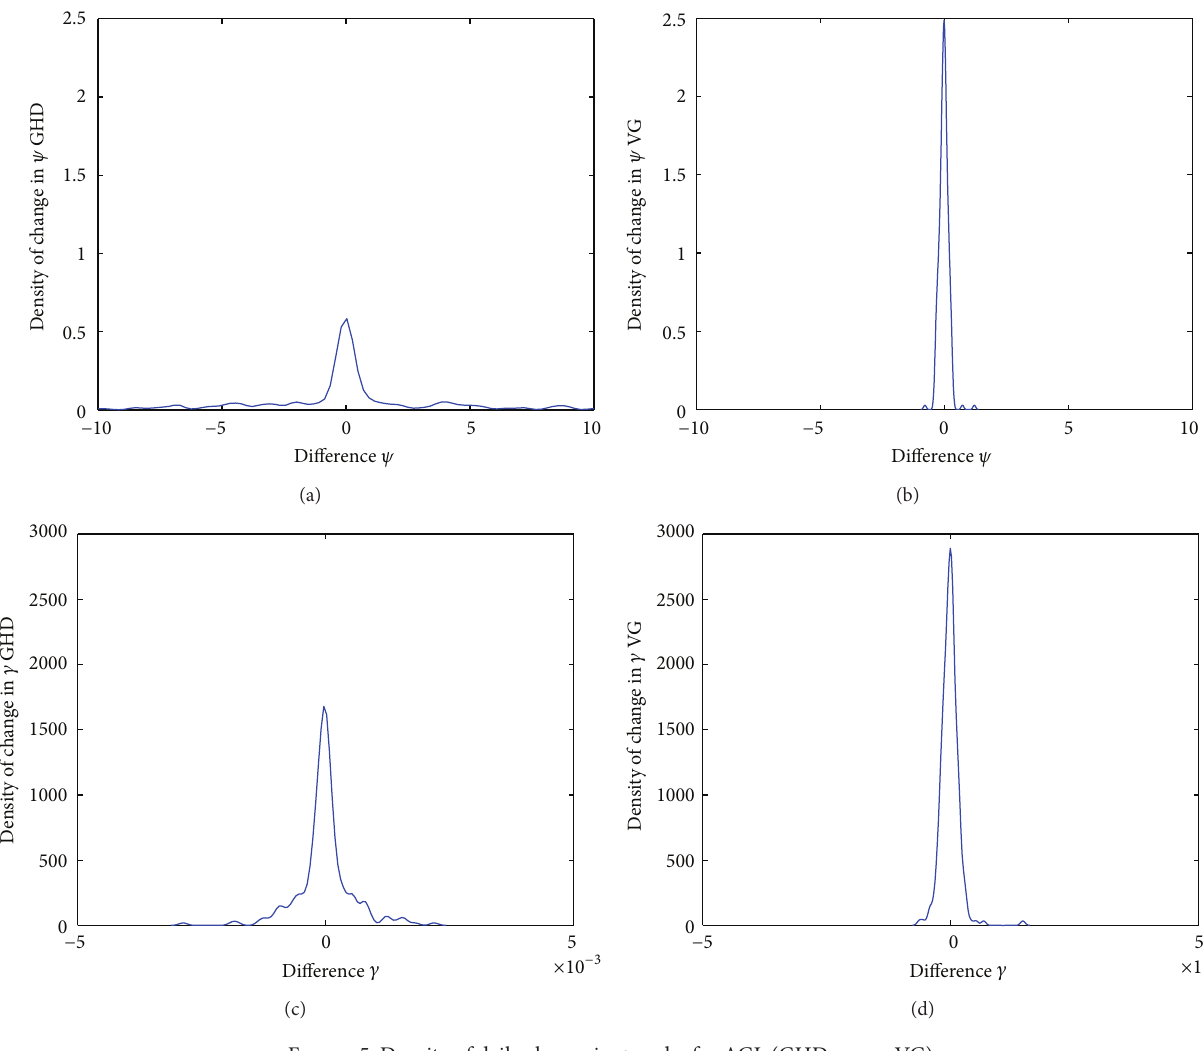
Figure 5: Density of daily change in 𝜓 and 𝛾 for AGL (GHD versus